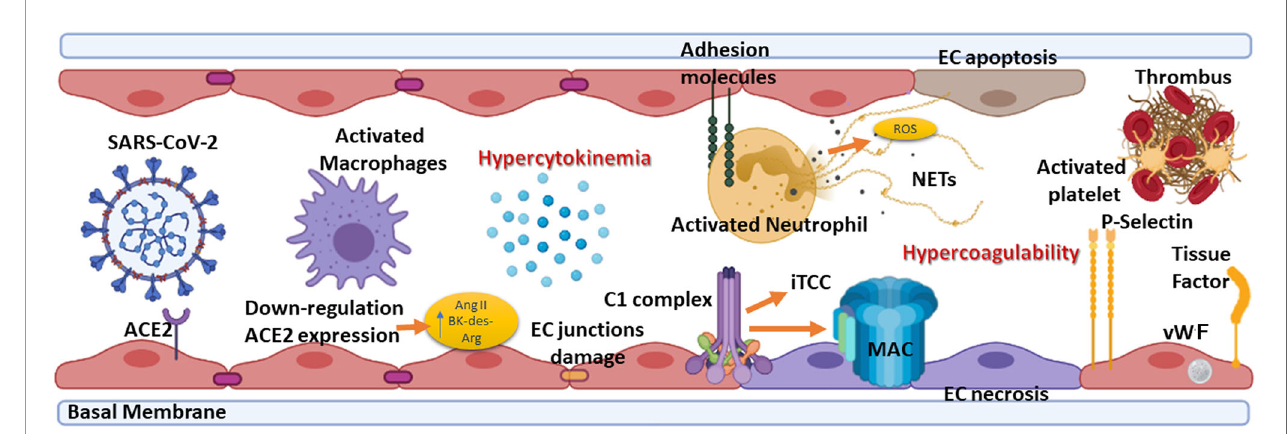
FIGURE 3 | Summary of the elements involved in endotheliitis. COVID-19 pathogenesis is characterized by an initial virus-induced injury leading to multi-organ failure, coupled with an intense in fl ammatory reaction, endothelial cell (EC) injury, and a prothrombotic coagulopathy with thrombotic events. The hypercytokinemia induced by severe acute respiratory syndrome coronavirus 2 (SARS-CoV-2) causes the expression by ECs of adhesion molecules such as intercellular adhesion molecule 1 (ICAM-1), vascular cell adhesion molecule 1 (VCAM-1) and P-selectin. Neutrophils are recruited and contribute to this process through the release of neutrophil extracellular traps (NETs), which directly activate factor XII and, thus, the contact-dependent pathway of coagulation. NETs also bind von Willebrand factor (vWF) and help to recruit platelets. The feed-forward loop is ampli fi ed by the effect of P-selectin, vWF, and fi brinogen expression by ECs in response to hypercytokinemia, causing platelets to directly bind to ECs leading to their activation and hypercontractility, which can lead to disruption of cell-cell junctions and vascular leakage. ACE2, Angiotensin-converting enzyme 2; Ang II, Angiotensin II; BK, Bradykinin; MAC, Membrane attack complex; iTCC, Inactive terminal complement complex; ROS, Reactive oxygen